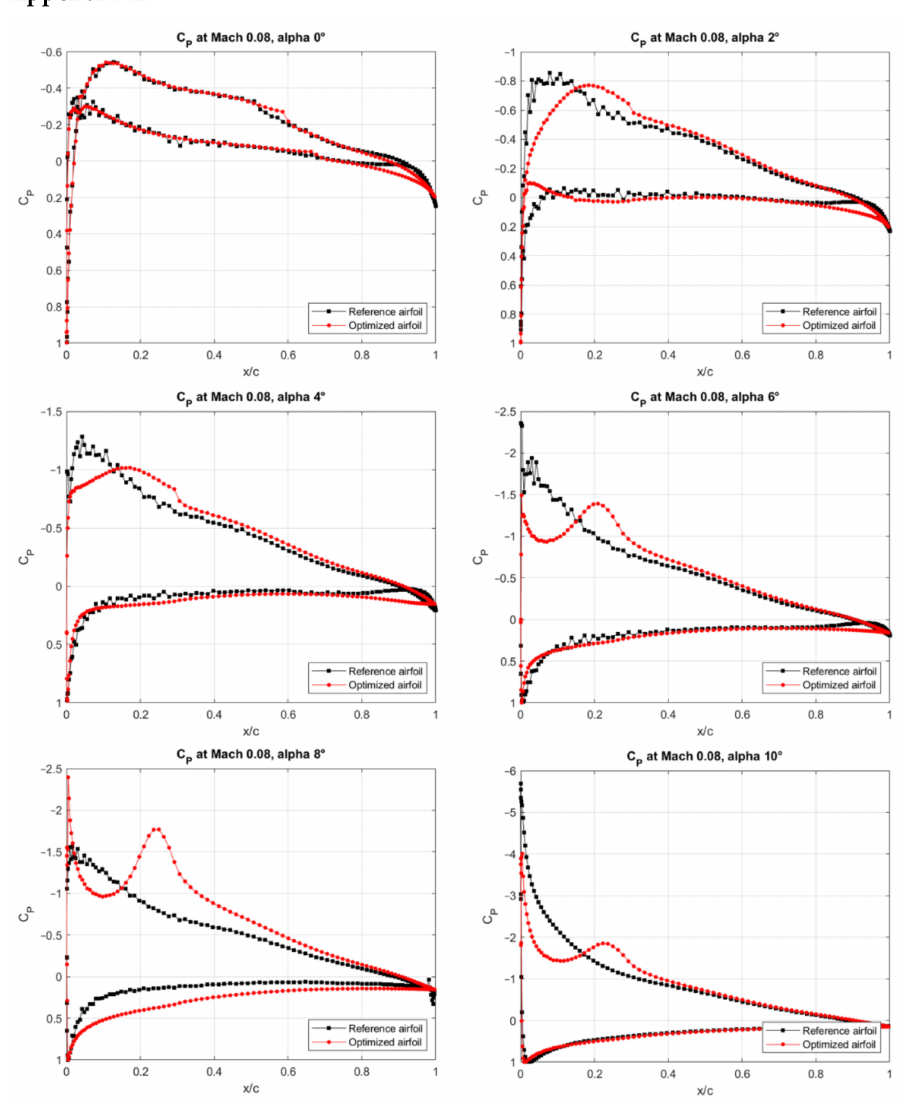
Figure A1. Cp distribution versus the chord obtained for the UAS-S45 optimized airfoil for M =